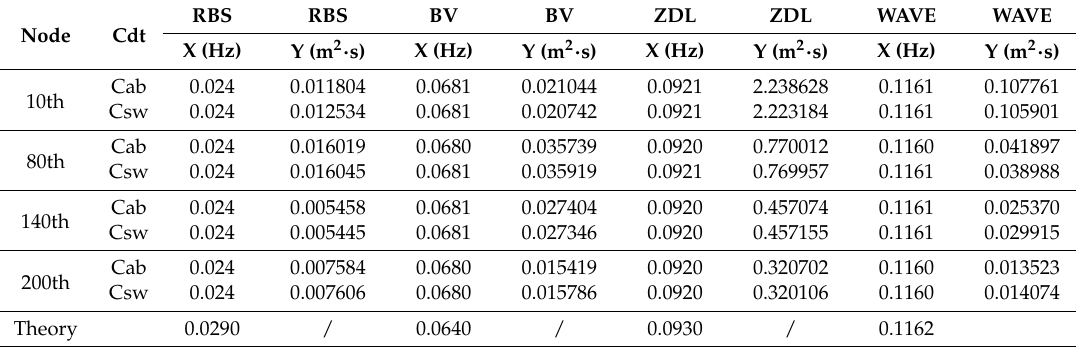
Table 12. Structural frequencies and amplitudes of different loads.